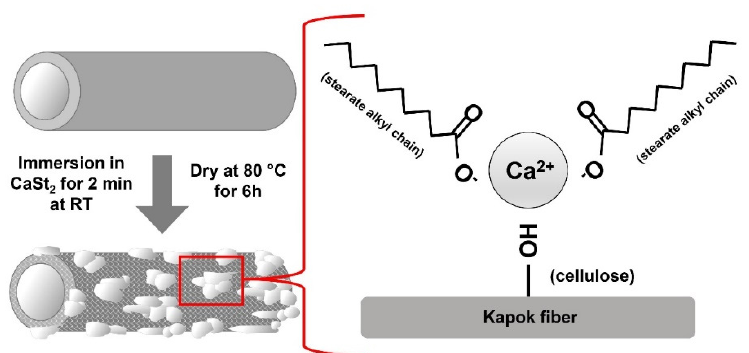
Figure 5. (Color online) Schematic representation of the one-step modification of kapok fibers with calcium stearate.